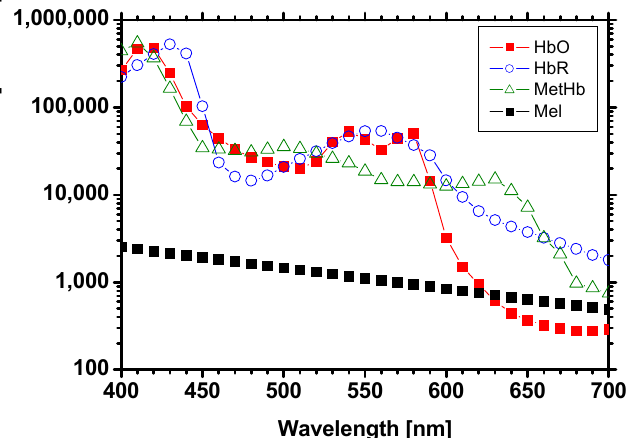
Figure 1. Extinction coefficient spectra of typical hemoglobin derivatives (oxygenated hemoglobin HbO 10 , deoxygenated hemoglobin HbR 10 , and methemoglobin 11 ) and melanin 12 in visible wave- length region between 400 and 700 nm.